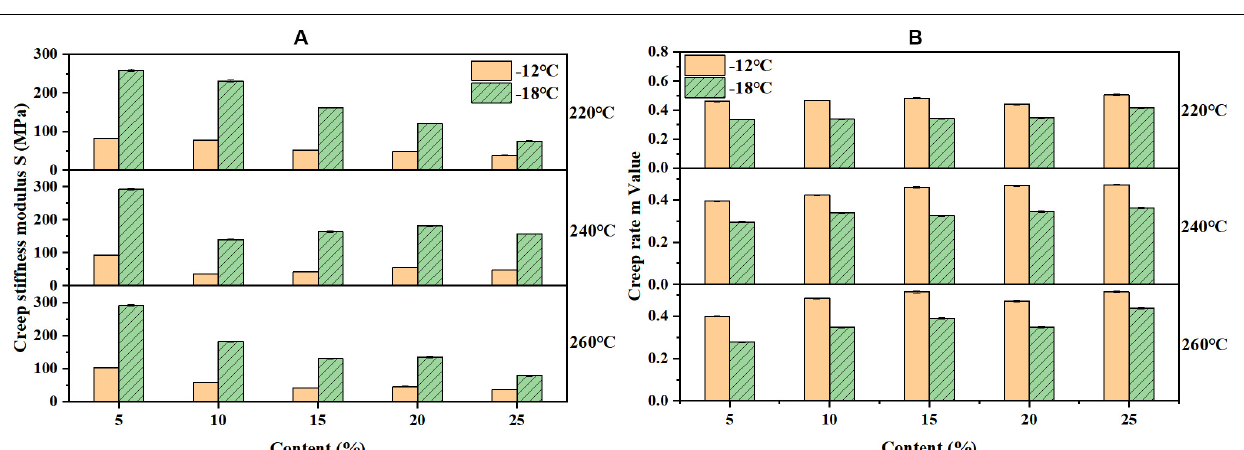
FIGURE 7 | Creep stiffness and m -value of TB-B. (A) Creep stiffness of TB-B. (B) m -value of TB-B.